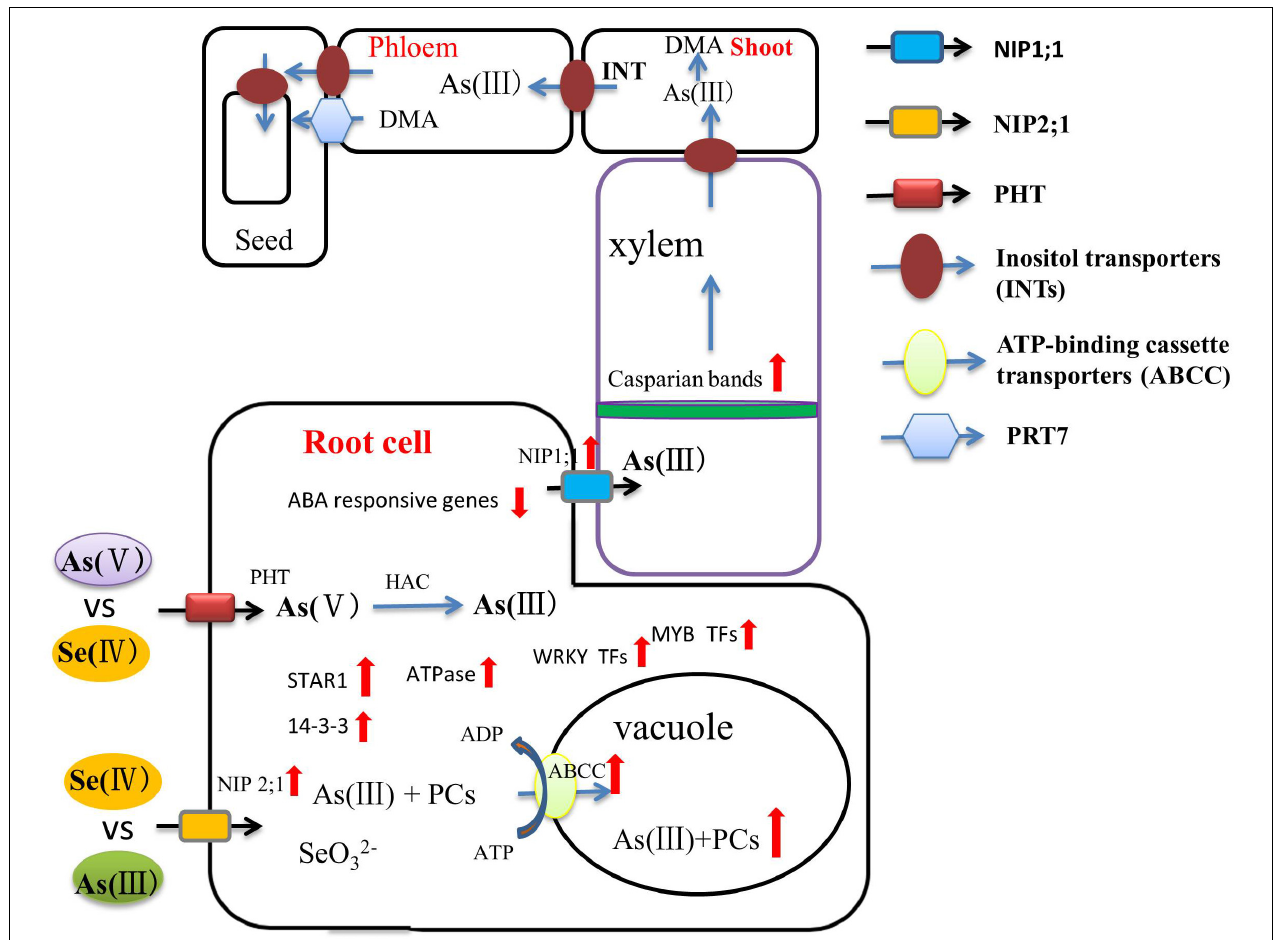
FIGURE 2 | A flow diagram of the role of Se in regulating As bioavailability and accumulation and transport through xylem and phloem to the grains. Inositol transporters (INTs) may be involved in the mobilization of As from source tissues to the phloem for subsequent transport to seed tissues. As(III) and Se(IV) enter the plant root system by sharing the NIP2;1 transporter. As(V) and Se(IV) are absorbed by plant roots via phosphate transporters. ABC transporters can sequester As(III)-PCs complexes into vacuoles. Se significantly limits the transport of As from the root to the grain through enhanced development of apoplastic barriers and up-regulation of related genes (red